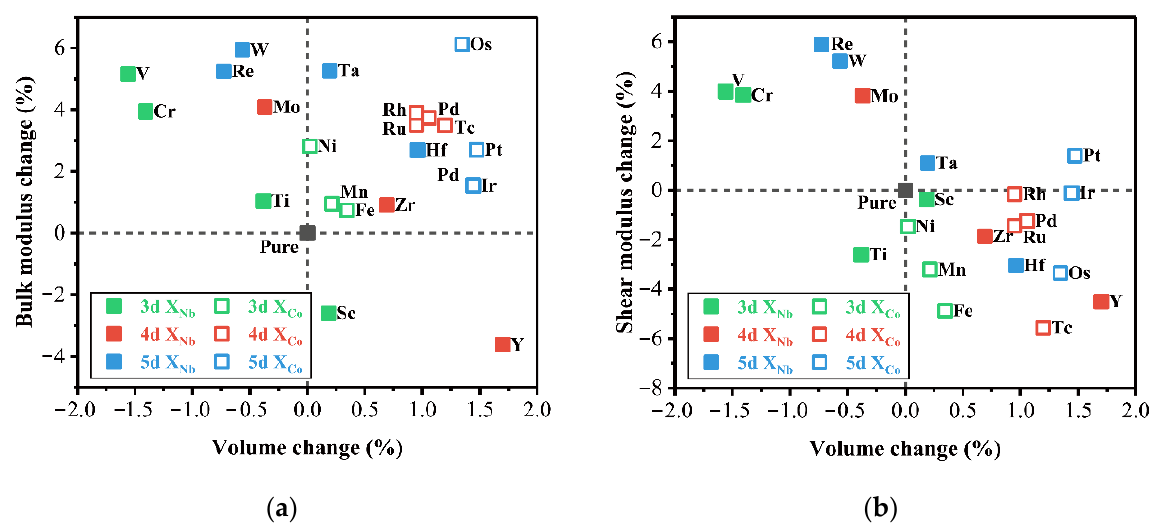
Figure 5. Calculated elastic parameters change as a function of volume change for Co 3 Nb compounds with the transition elements X substituted Co and Nb site: ( a ) bulk modulus B ; ( b ) shear modulus G . Solid and open symbol represent X prefer to occupy Nb and Co site, respectively.